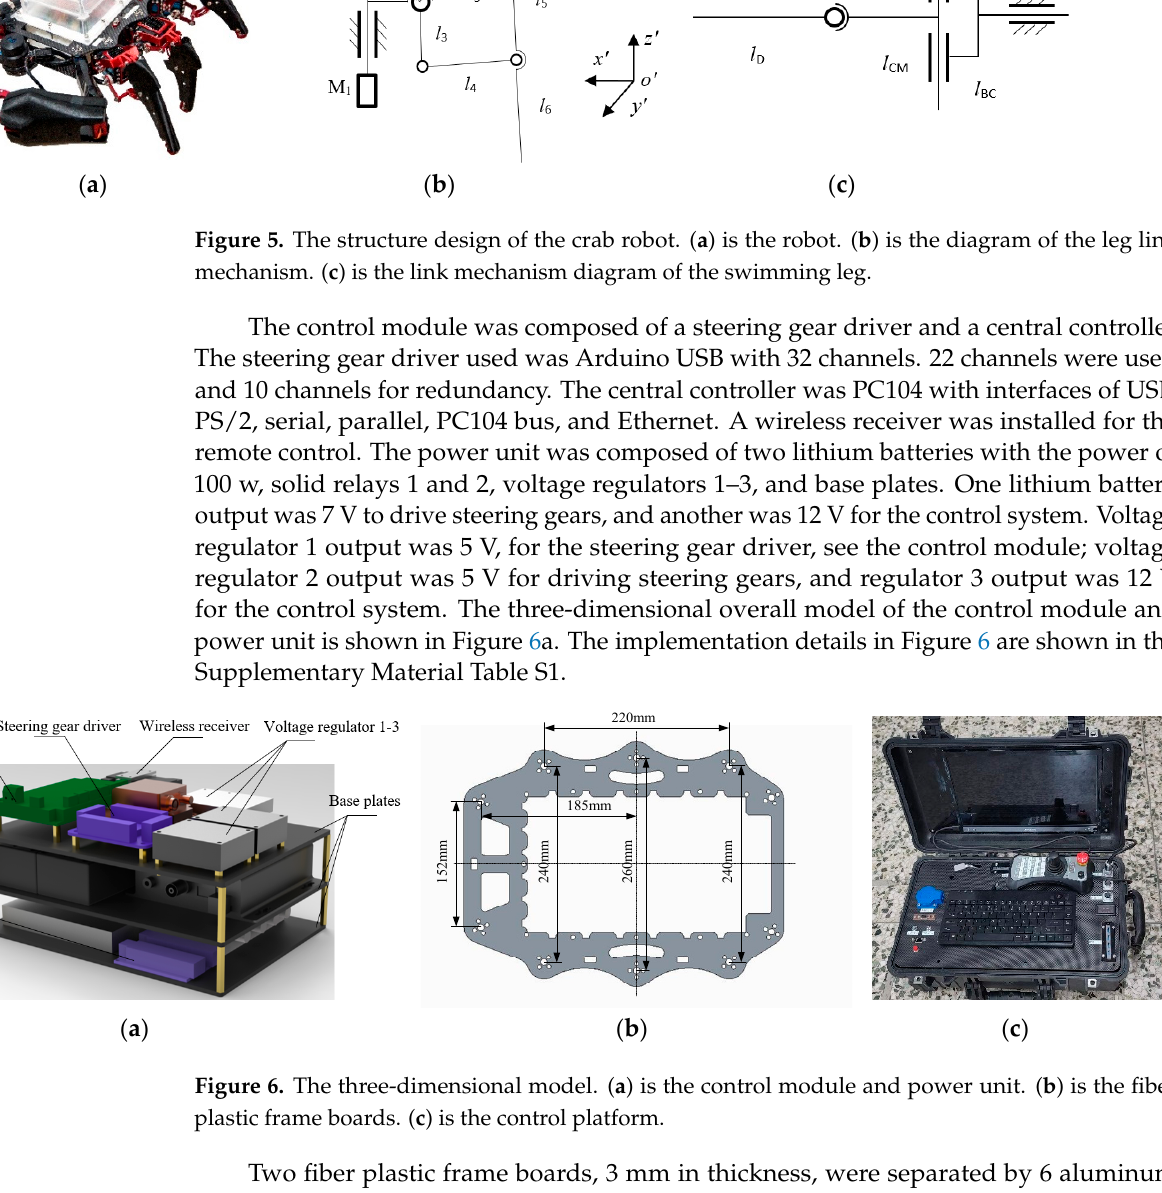
P Figure 7. Kinematic model of walking leg. The D-H parameters of the walking leg are shown in Table 1. l 1 , l 2 , and l are the lengths of each link of the walking leg. 𝜃 (cid:2869) , 𝜃 (cid:2870) , and 𝜃 (cid:2871) are the rotation angles of each joint. 𝑞 (cid:2869) = 𝜃 (cid:2869) , 𝑞 (cid:2870) = 𝜃 (cid:2870) – π /2, 𝑞 (cid:2871) = π /2 + 𝑟 (cid:2870) – 𝜃 (cid:2870) , are the angular displacements of each joint, respectively.